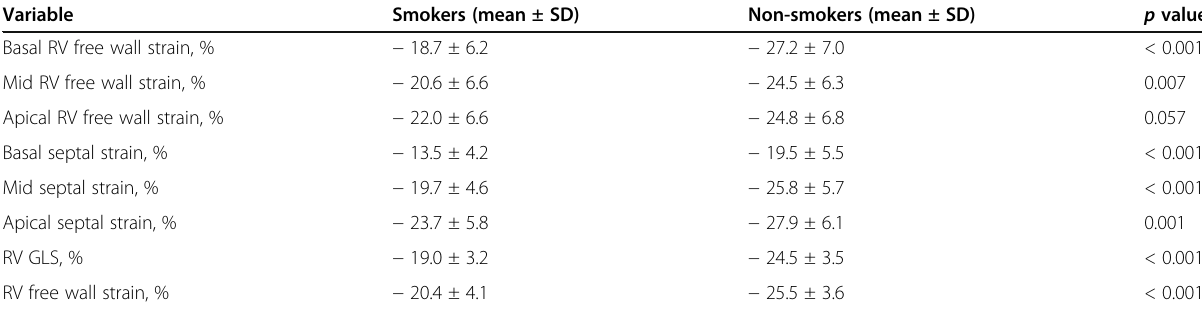
Table 3 Right ventricular strain of the 2 groups